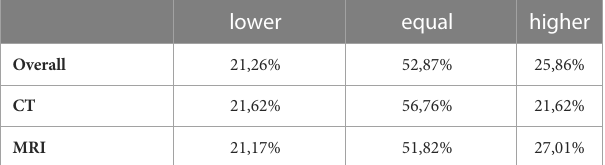
TABLE 5 Correlations between CT and MRI staging examinations (cN) and histopathological fi ndings (pN) in the exact N-stage. lower equal higher